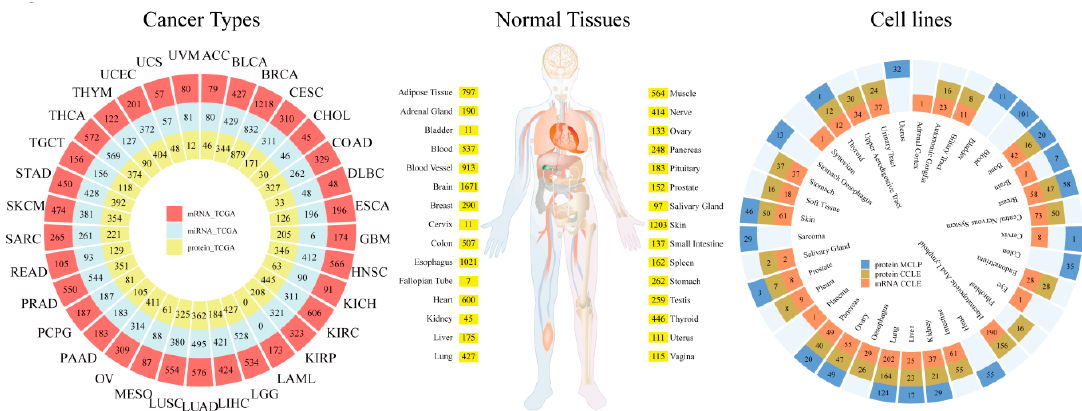
Figure 1. The data summary of the Gene Expression Display Server (GEDS). GEDS collected expression data of cancer types, normal tissues, and cell lines from The Cancer Genome Atlas (TCGA), Genotype-Tissue Expression (GTEx), Cancer Cell Line Encyclopedia (CCLE) and MD Anderson Cell Lines Project (MCLP).